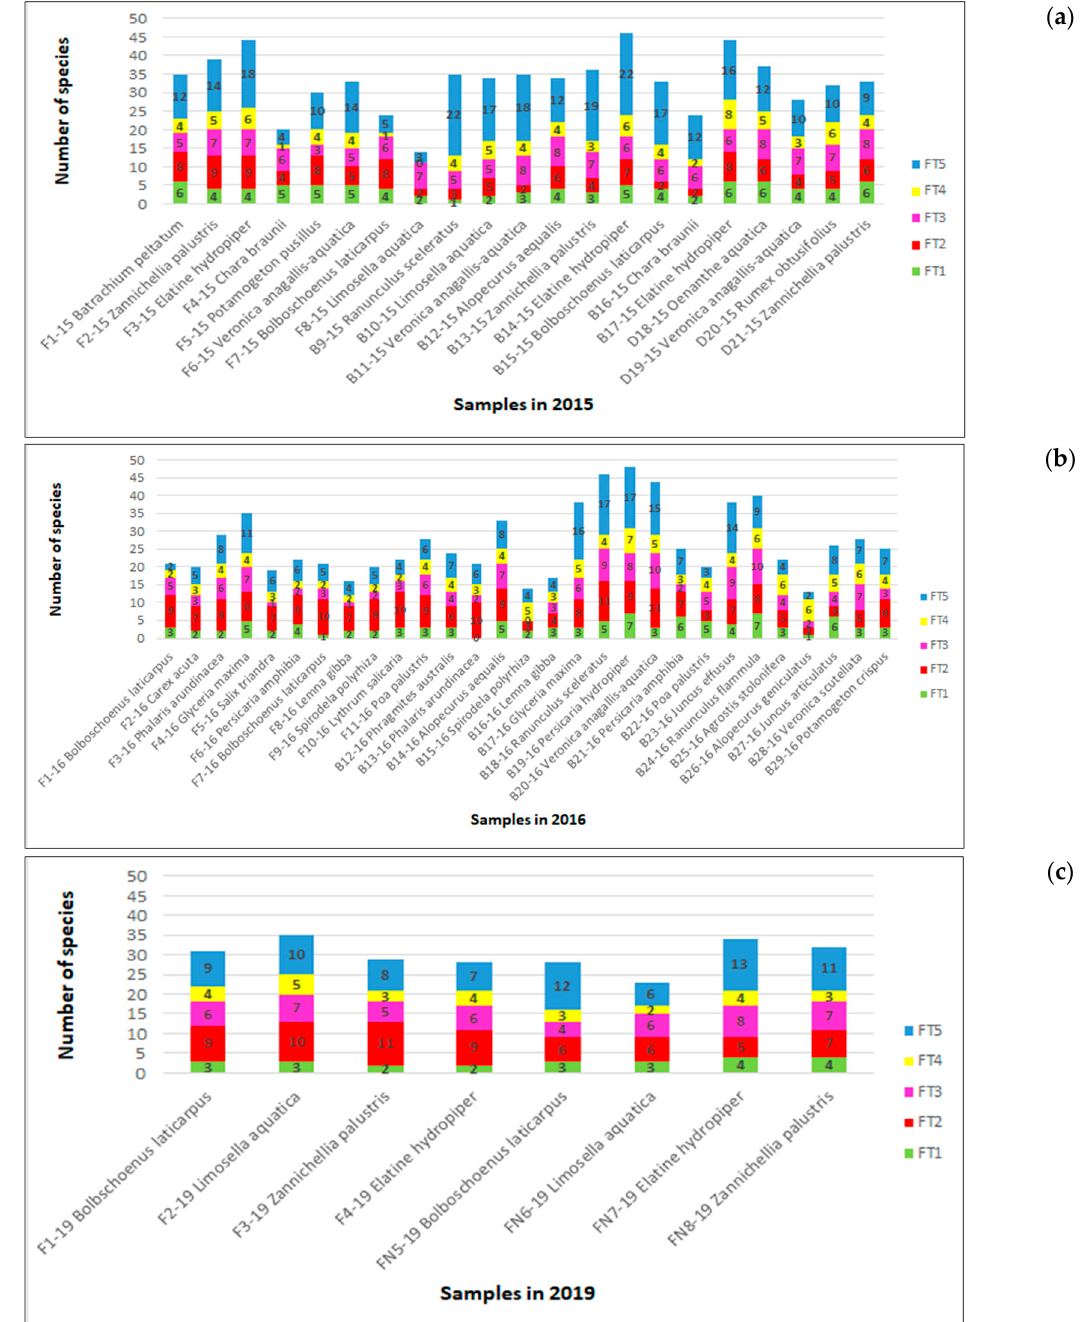
Figure 8. Diatom species numbers and representation of five diatom functional groups (FT1–FT5) among the species in individual samples (see Table S6) collected in the Dehtá ř fishpond. ( a ) Year 2015; ( b ) Year 2016; ( c ) Year 2019—only FD was sampled but two different microsites were included. Codes of the samples are according to Table S3. Host plant species is listed at each of the samples.